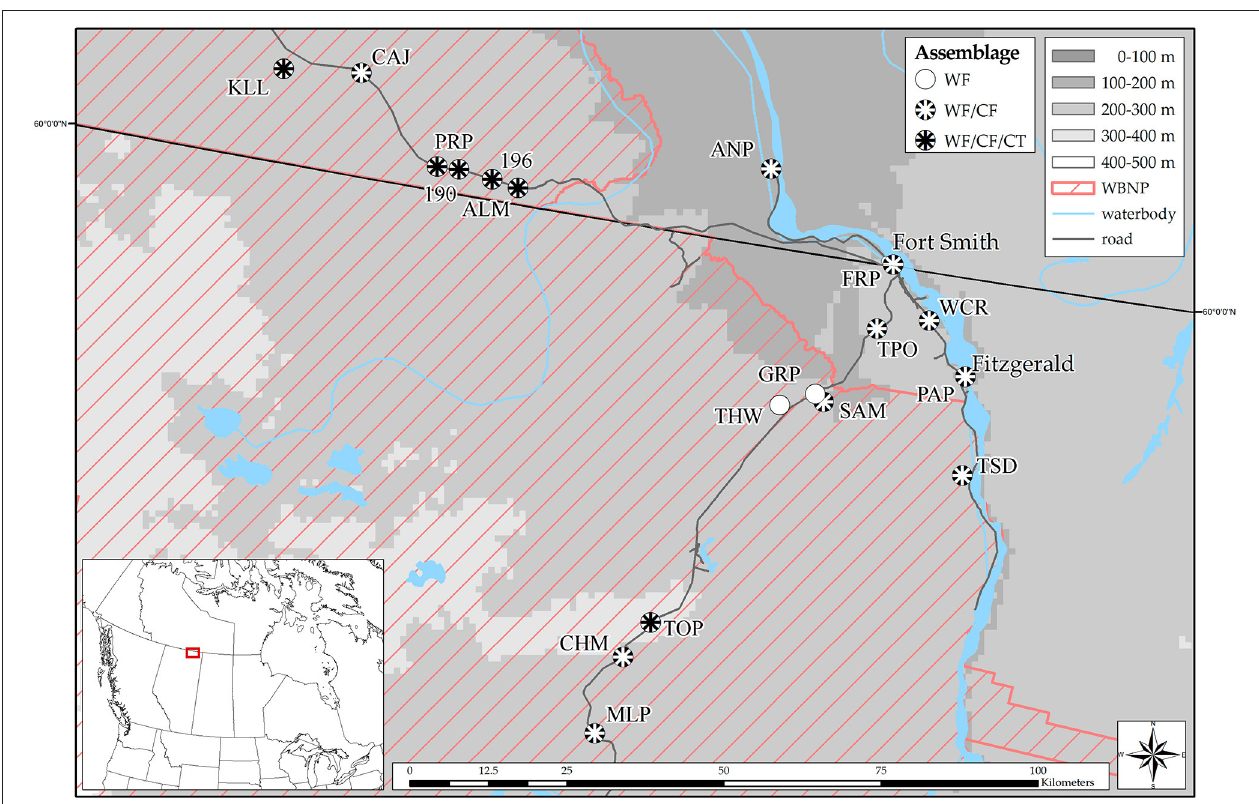
FIGURE 1 | Amphibian communities sampled in Alberta and the Northwest Territories in 2016 and 2017 (WF, wood frog; CF, boreal chorus frog; CT, Canadian toad; WBNP, Wood Buffalo National Park). Map was created using ArcMap10.5 (Esri, Redlands, CA,